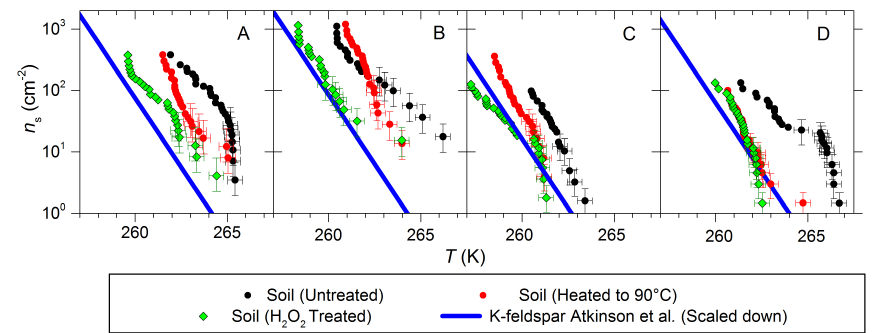
Fig. 6. Ice active site densities ( n s ) determined using microlitre drop freezing experiments for soils A–D (d T /d t = − 1Kmin − 1 ). Concentra- tions used ranged from 0.04–0.1wt% between the runs. Shown for comparison is the parameterisation of n s values for K-feldspar taken from Atkinson et al. (2013), which has been scaled down to the mass fraction of the feldspar in each of the soils as in Fig. 4. For clarity, error bars are only shown for the first 10 data points of each series.